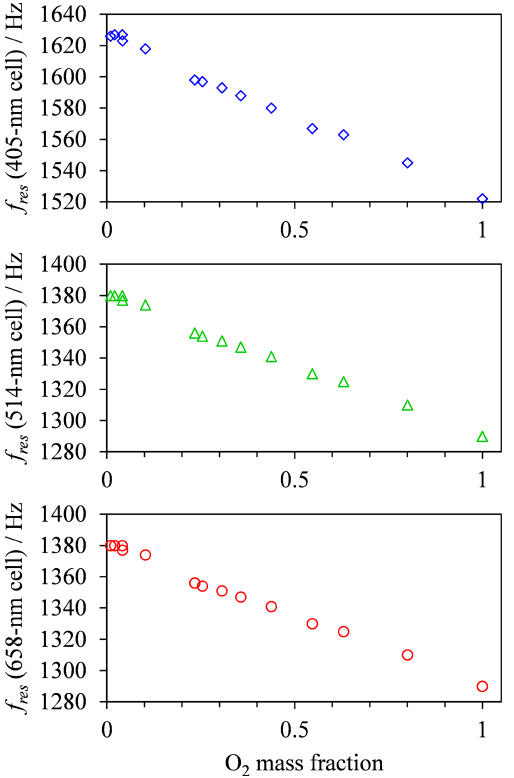
Figure 4. The variation in the mean measured PAS cell resonance frequency with O 2 mass fraction for each PAS channel used in this study.